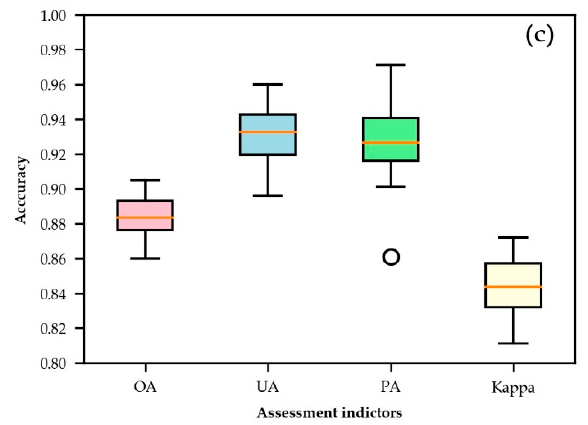
Figure 6. Changes in various assessment indicators with SVM, RF, and CART. ( a ) The result of SVM; ( b ) the result of RF; ( c ) the result of CART. See Table S1 and Table S2 for detail.